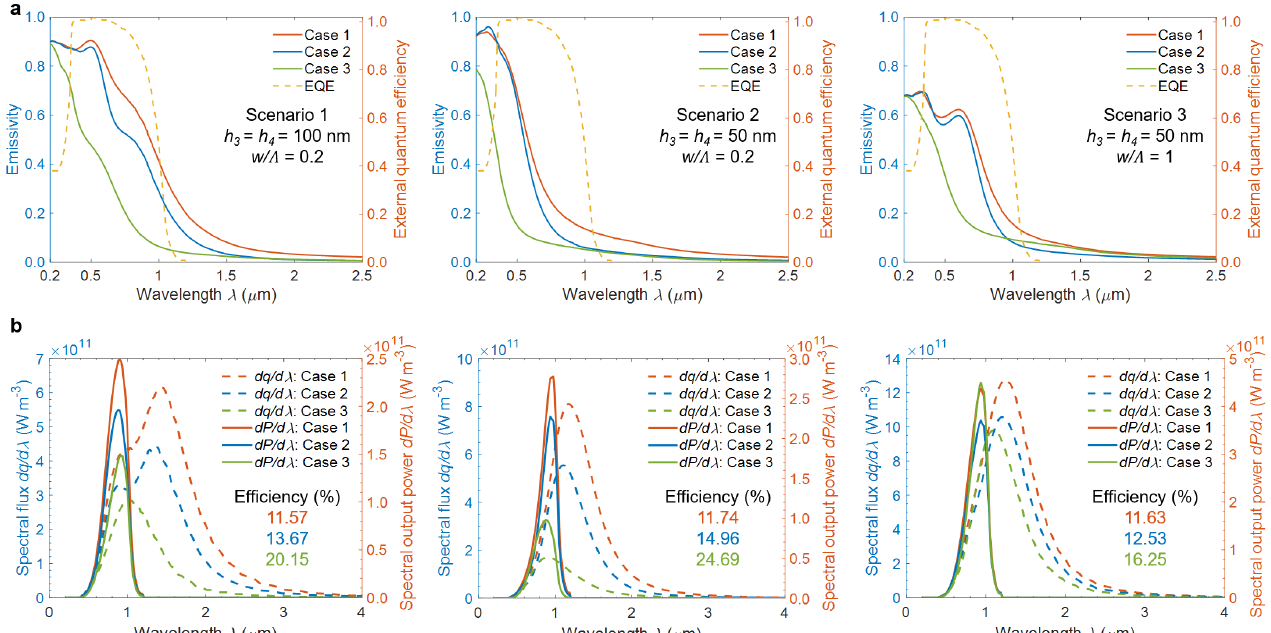
Figure 3. ( a ) Emissivity of the three thermal emitter cases. The yellow dashed line represents the EQE of the SiC/Si cell. ( b ) Spectral heat fluxes (dashed lines) as the separation gap is 100 nm and the corresponding spectral output power (solid lines) from the PV cell. From left to right, the two figures in each column correspond to scenario 1, 2 and 3, respectively. Case 1: B 4 C/B 4 C, Case 2: B 4 C/SiC, and Case 3: B 4